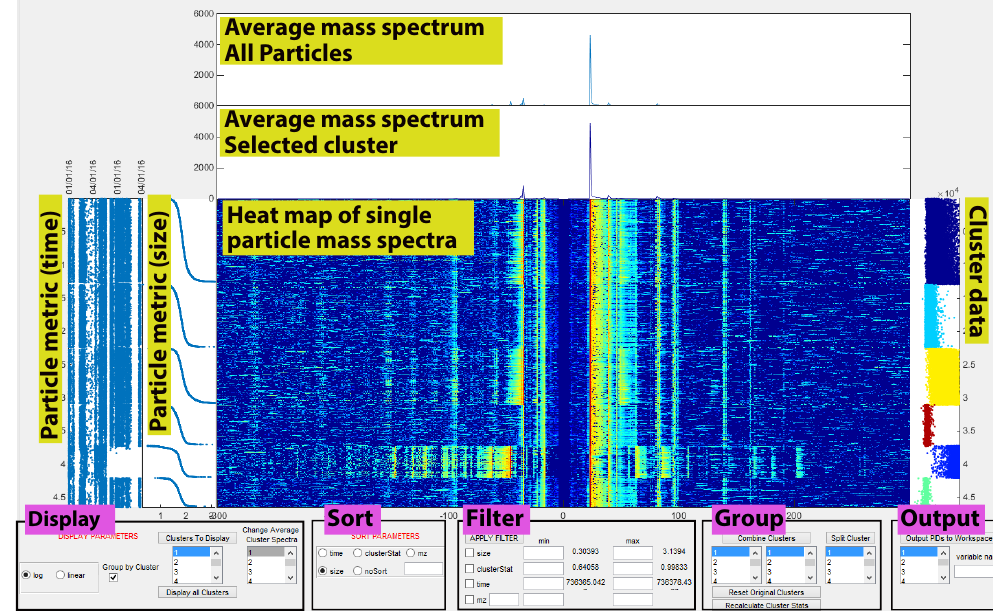
Figure 1. Screen capture of a guiFATES window with data from 46432 individual